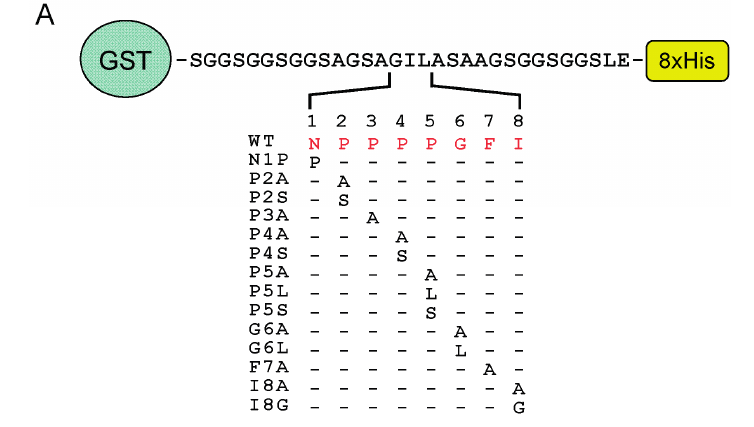
Figure 7. Co-immunoprecipitation assays of green fluorescent protein (GFP)-fused Sec31A mutants. At 24 h after HEK293T cells had been transfected with expression plasmids for GFP-Sec31A encoding wild-type (WT), ALG-2-binding site deletion mutant ( Δ 839 – 851 ) or amino acid substitution mutants ( G842A , F843A ), cells were lysed, and the obtained cleared cell lysates were subjected to immunoprecipitation with rabbit antiserum against GFP, as described in the Experimental Section. Cleared cell lysates (input) and immunoprecipitates (IP) were subjected to WB with anti-GFP (top) and anti-Sec31A (second row) and far-Western blot (FW) with biotin-labeled ALG-2 (bio-ALG-2, third row), as indicated. WB was also performed with anti-ALG-2 (bottom), and the area surrounded by the broken line indicates an image of longer exposure time for chemiluminescence reaction. Asterisk, immunoglobulin light chain (IgG-L). Input, 2.5%. Representative data obtained from three independent experiments are